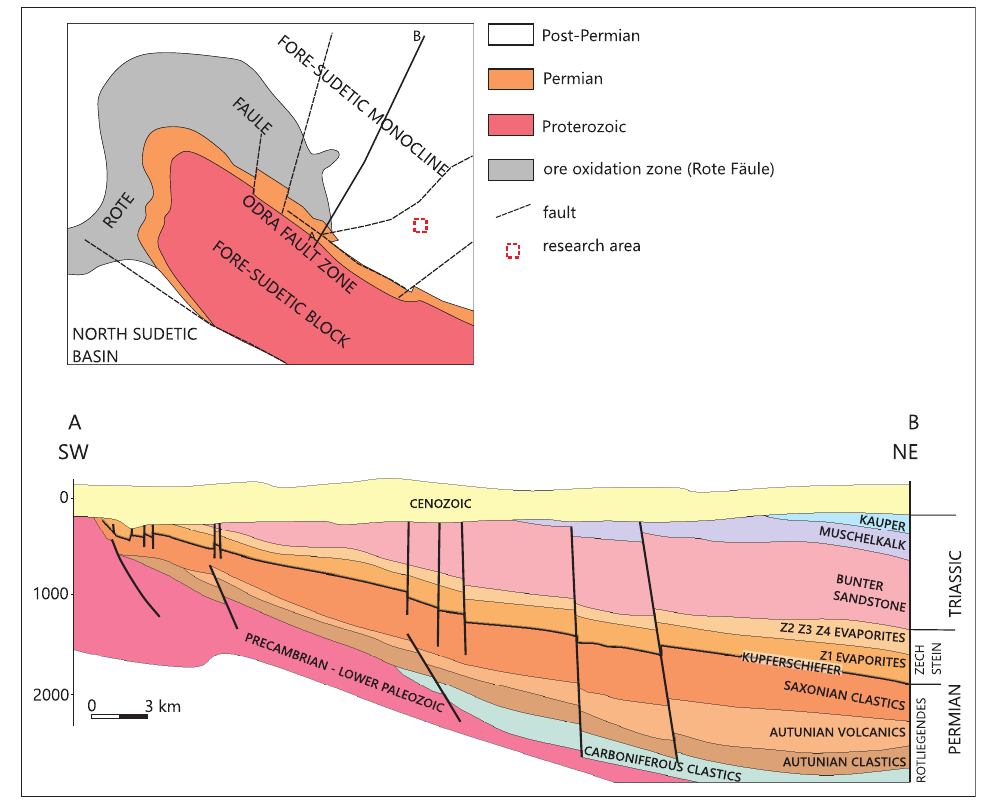
Figure 3. Location and geologic setting of the research area. Geologic cross-section along line A–B in upper figure